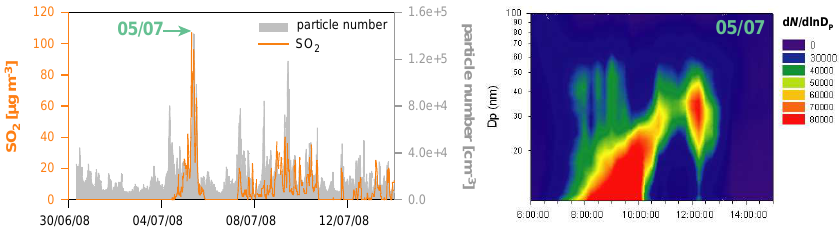
Fig. 8 Fig. 8. Time series over the sampling period of SO 2 [µgm − 3 ] and particle total number [cm − 3 ] measured using a SMPS (11–1000nm).